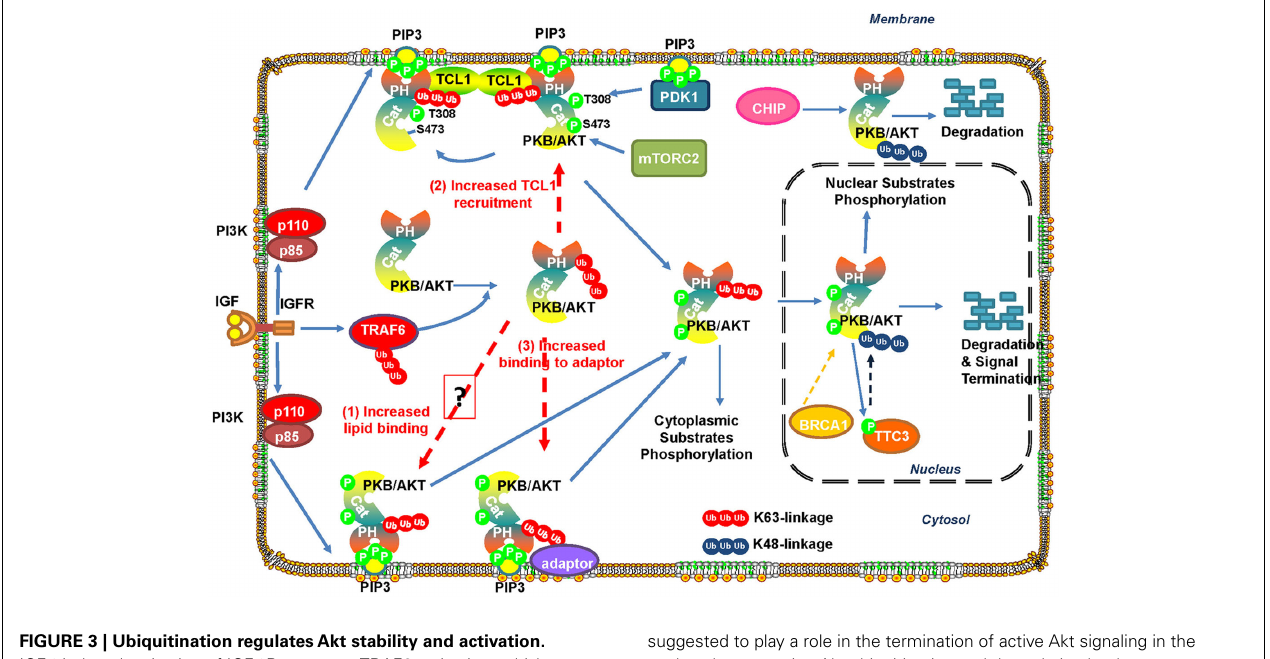
FIGURE 3 | Ubiquitination regulatesAkt stability and activation. IGF-1-induced activation of IGF-1R promotesTRAF6 activation, which then triggers K63-linked ubiquitination of Akt and promotes Akt membrane recruitment and subsequent phosphorylation by PDK1 and mTORC2. Active Akt then phosphorylates its substrates in the cytoplasm and nucleus to exert its biological functions. E3 ligaseTTC3 has been